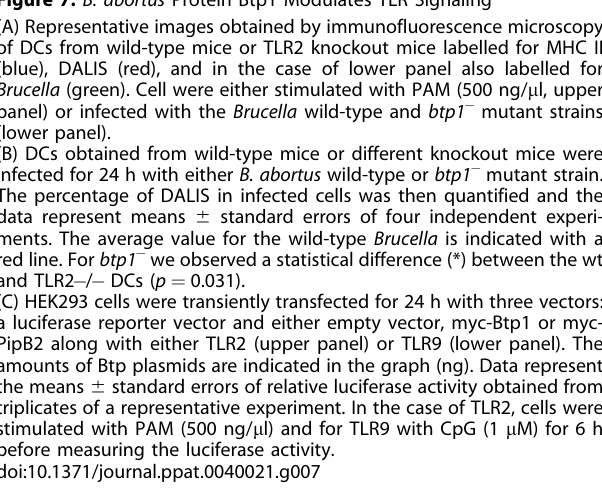
Figure 7. B. abortus Protein Btp1 Modulates TLR Signaling (A) Representative images obtained by immunofluorescence microscopy of DCs from wild-type mice or TLR2 knockout mice labelled for MHC II (blue), DALIS (red), and in the case of lower panel also labelled for Brucella (green). Cell were either stimulated with PAM (500 ng/ l l, upper panel) or infected with the Brucella wild-type and btp1 (cid:2) mutant strains (lower panel). (B) DCs obtained from wild-type mice or different knockout mice were infected for 24 h with either B. abortus wild-type or btp1 (cid:2) mutant strain. The percentage of DALIS in infected cells was then quantified and the data represent means 6 standard errors of four independent experi- ments. The average value for the wild-type Brucella is indicated with a red line. For btp1 (cid:2) we observed a statistical difference (*) between the wt and TLR2 (cid:2) / (cid:2) DCs ( p ¼ 0.031). (C) HEK293 cells were transiently transfected for 24 h with three vectors: a luciferase reporter vector and either empty vector, myc-Btp1 or myc- PipB2 along with either TLR2 (upper panel) or TLR9 (lower panel). The amounts of Btp plasmids are indicated in the graph (ng). Data represent the means 6 standard errors of relative luciferase activity obtained from triplicates of a representative experiment. In the case of TLR2, cells were stimulated with PAM (500 ng/ l l) and for TLR9 with CpG (1 l M) for 6 h before measuring the luciferase activity.